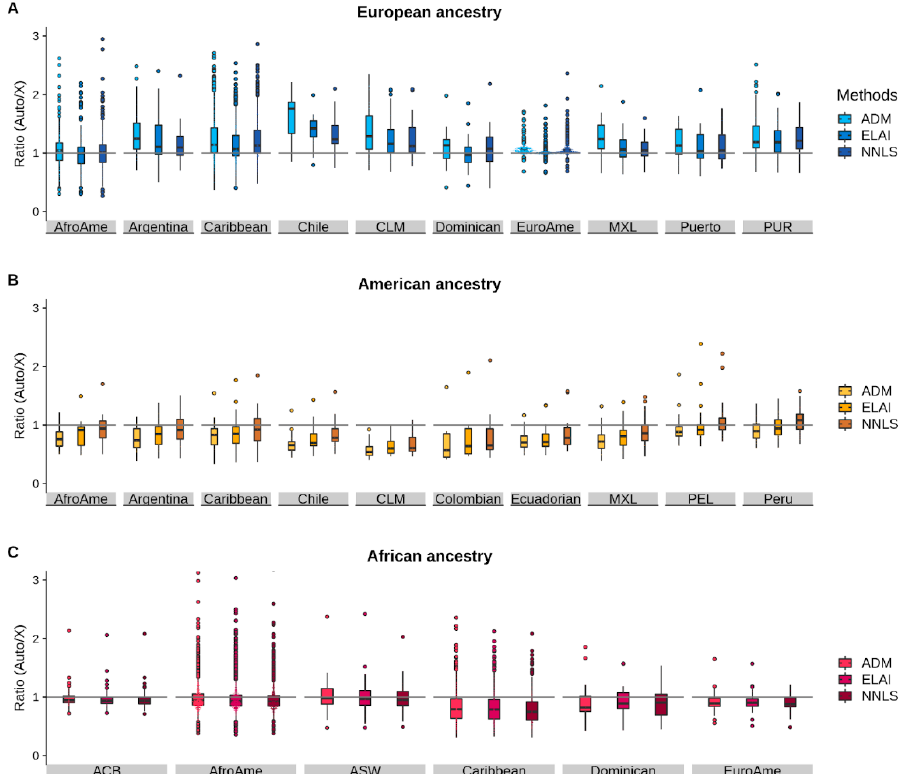
Figure 3. Ratios of autosomal vs. chromosome X continental proportions in admixed American populations. Each boxplot shows the ratio of autosomal to chrX ancestry proportion for ( A ) European, ( B ) Indigenous American, and ( C ) African continental components as inferred by ADMIXTURE, ELAI and NNLS in admixed American populations. Boxplots refer to the interquartile range, and whiskers refer to data points not exceeding the interquartile range more than 1.5 times. All the other data points are considered outliers and shown as dots. This Figure was realised using the library ggplot2 of R. These results are also reported in Supplementary Table 1E–H.